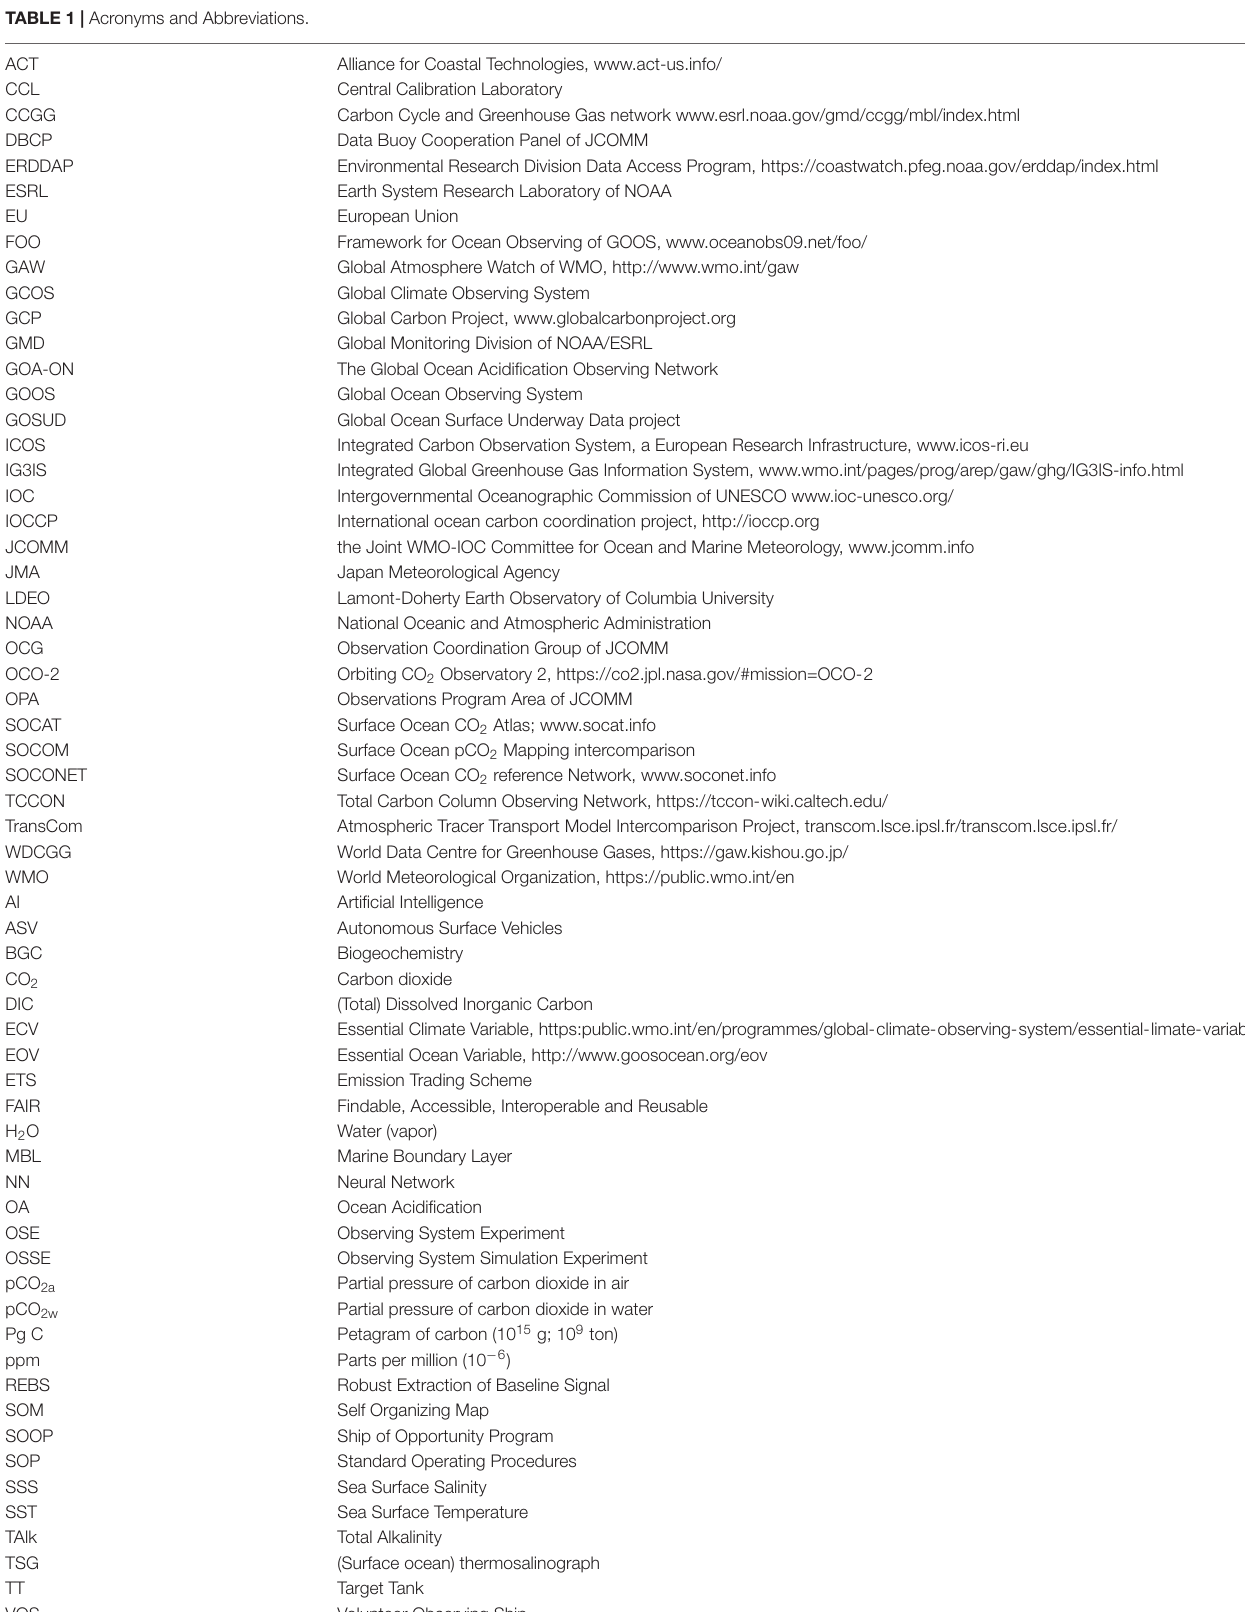
TABLE 1 | Acronyms and